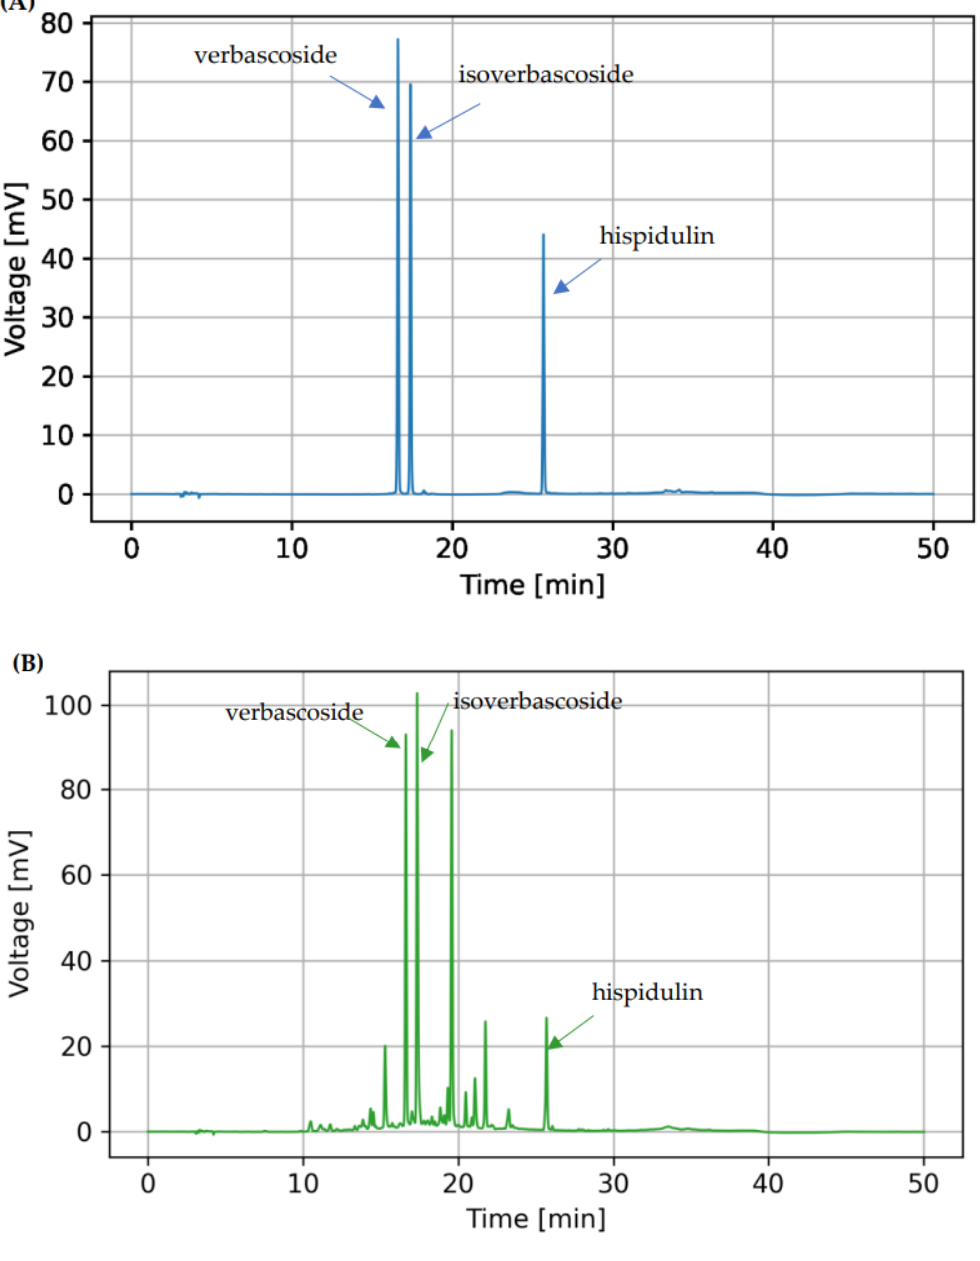
Figure 1. ( A ) HPLC chromatogram of verbascoside (5 µg/mL), isoverbascoside (5 µg/mL), and hispidulin (0.9 µg/mL) standards and ( B ) a HPLC chromatogram of 200 µg/mL C. chinense leaf